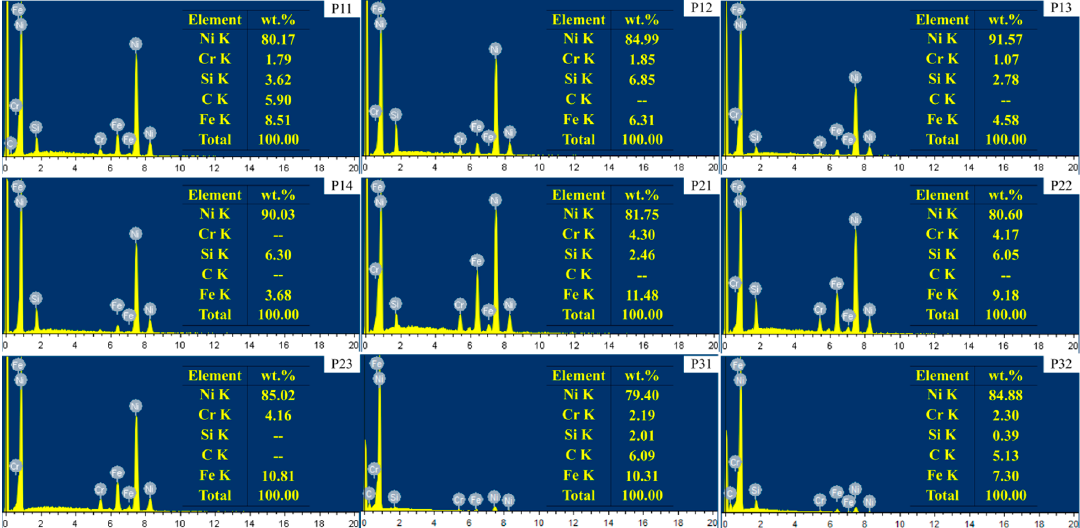
Figure 9. The Corresponding EDS results in Figures 7 and 8.